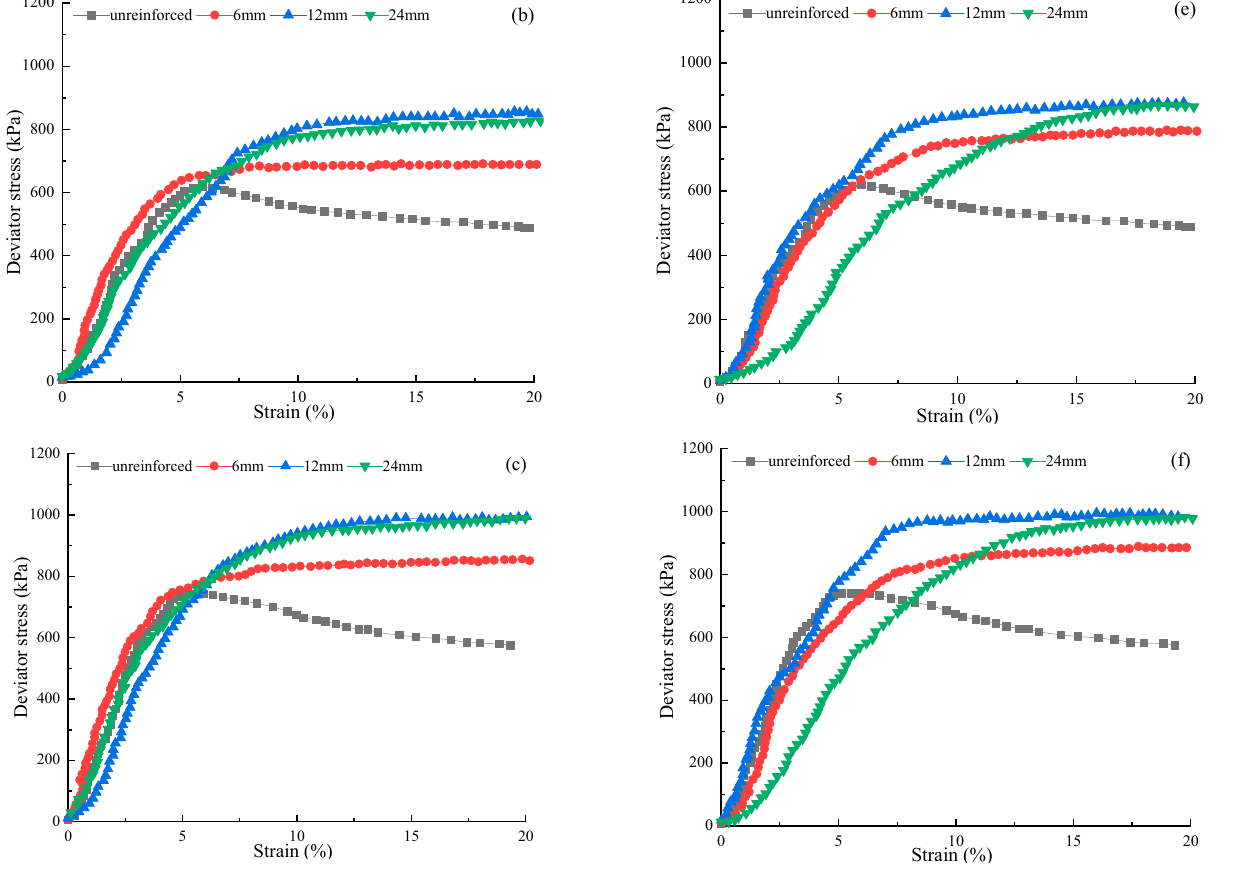
Figure 6. The relation of stress–strain curves of polypropylene (PP) fiber-reinforced FAS specimens: ( a ) FC = 1.0%, FL = 6 mm under 200 kPa, ( b ) FC = 1.0%, FL = 12 mm under 300 kPa, ( c ) FC = 1.0%, FL = 24 mm under 400 kPa, ( d ) FC = 1.5%, FL = 6 mm under 200 kPa, ( e ) FC = 1.5%, FL = 12 mm t under 300 kPa, ( f ) FC = 1.5%, FL = 24 mm under 400 kPa.